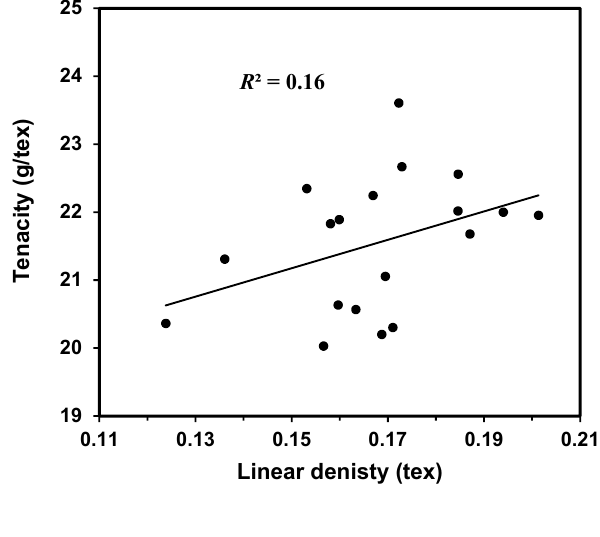
Figure 4. Correlation between fiber bundle tenacity and linear